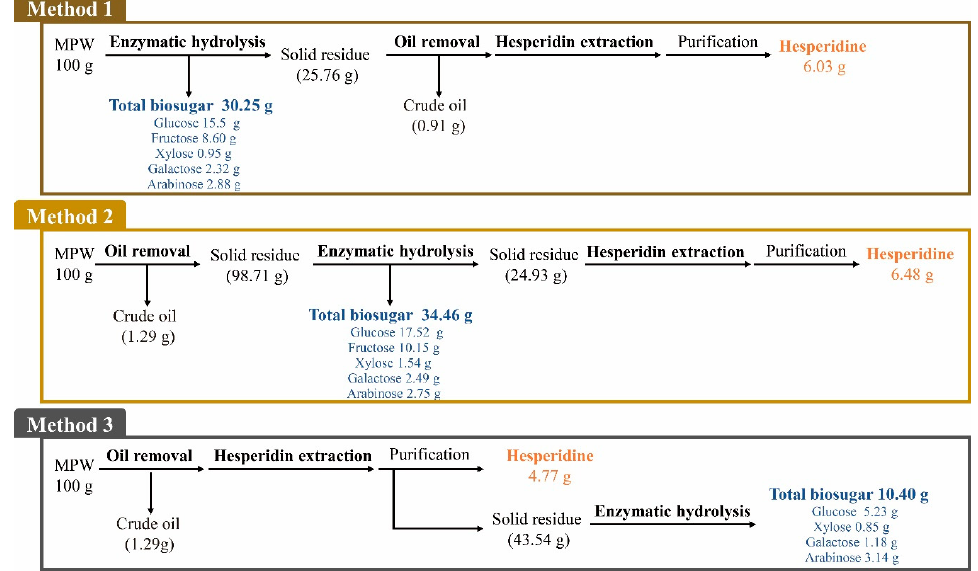
Figure 6. Overall mass balance for each method to produce biosugar and hesperidin from MPW.